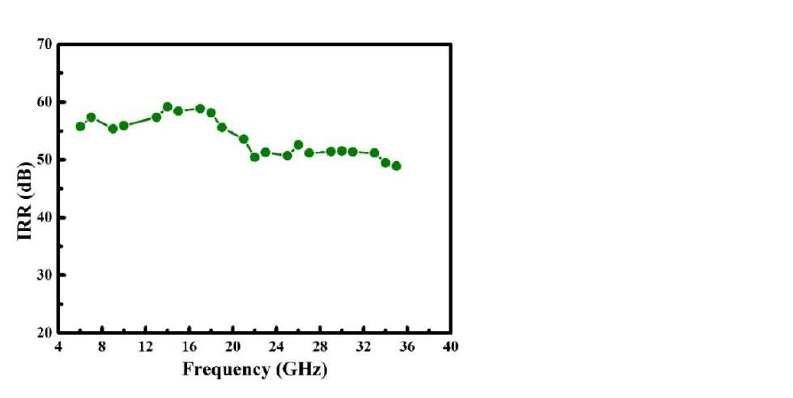
Figure 7. Output power of the IF signal after the RF signal is down-converted and with the DSP operation, where the quadrature coupling method of the two polarized photocurrents are set to be